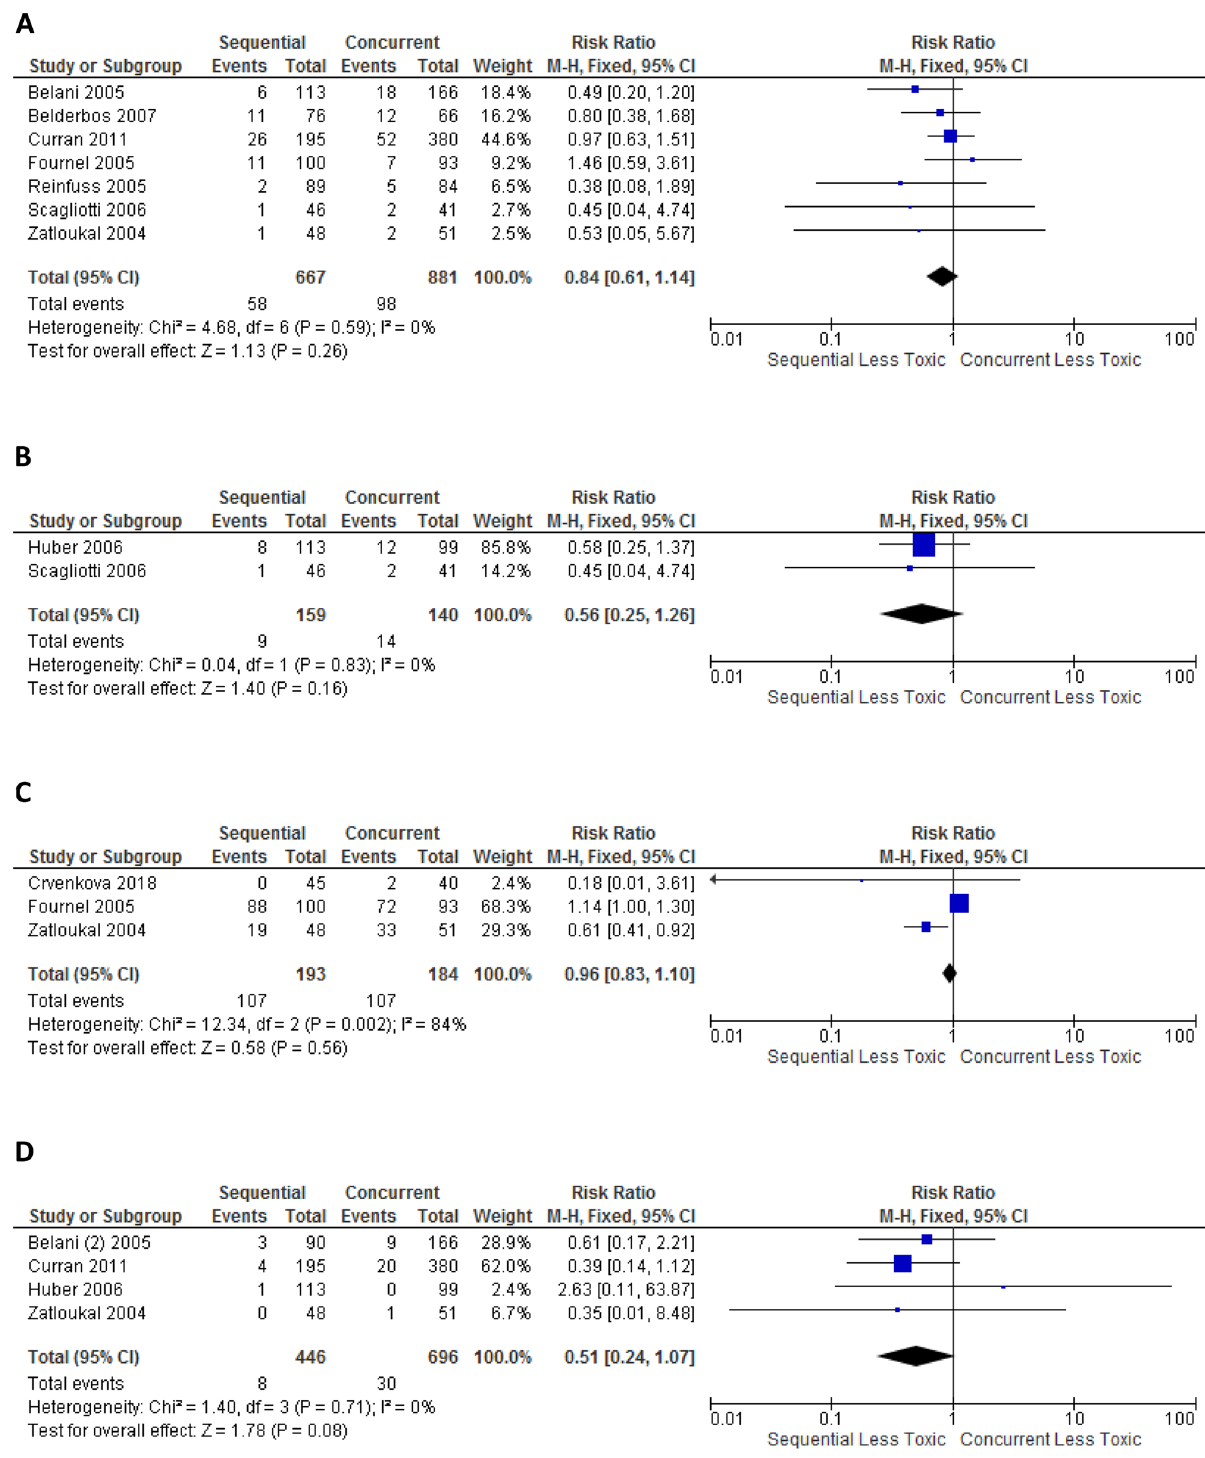
Figure 4. Forest plot showing toxicity risk ratio (RR), comparison between sequential versus concurrent chemoradiation for: ( A ) grade ≥ 3 pneumonitis; ( B ) any grade pneumonitis; ( C ) grade ≥ 3 neutropenia; ( D ) grade ≥ 3 cardiac event, generated with Cochrane Review Manager version